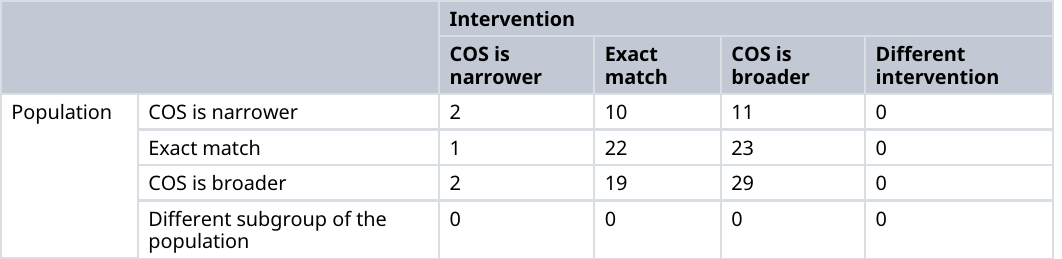
COS, core outcome set.